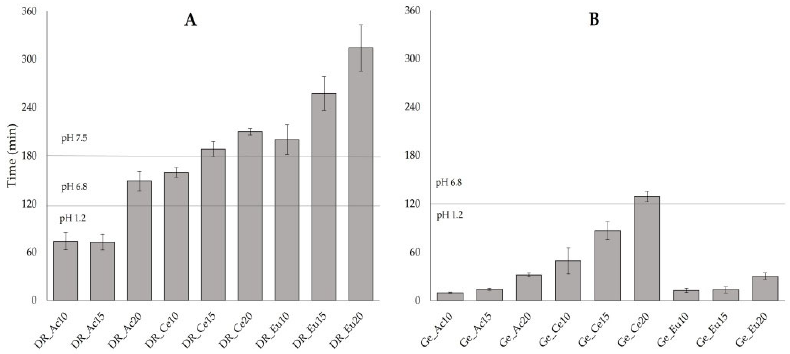
Figure 5. Time of disintegration under various conditions (pH 1.2; followed by the pH 6.8 and pH 7.5) of enteric ‐ coated capsules: ( A ) DRcaps TM capsules; ( B ) hard gelatin capsules. Mean values ± SD ( n = 6).